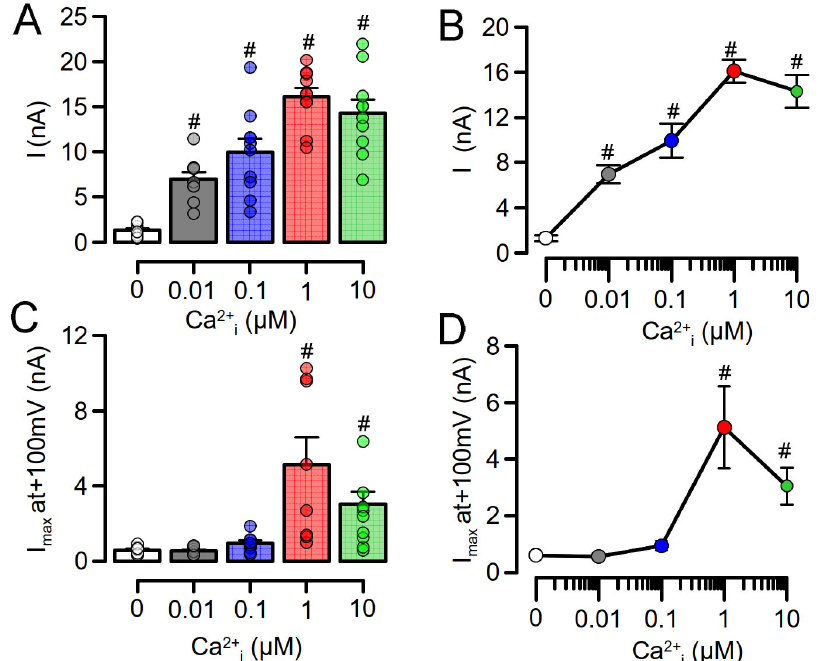
Figure 2. Enhanced Ca 2+ sensitivity of overexpressed TMEM16A . Patch pipettes were filled with solutions containing different free Ca 2+ concentrations (0–10 μ M). At 0 μ M pipette Ca 2+ no TMEM16A, whole cell currents were observed in overexpressing HEK293 cells or CFBE cells expressing endogenous TMEM16A. ( A , B ) Whole cell currents were activated in overexpressing HEK293 cells at Ca 2+ concentrations as low as 0.01 μ M. ( C , D ) TMEM16A currents in CFBE cells were only observed at 1 μ M Ca 2+ . Mean ± SEM (n = number of experiments). # Significant activation when compared to 0 μ M Ca 2+ ( p < 0.05; ANOVA).